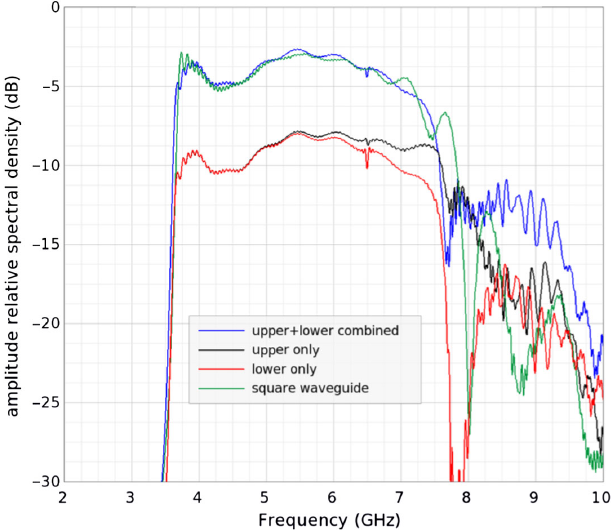
FIG. 19. Comparison of amplitude spectra for the individual, combined, and square waveguide modes of the FDTD